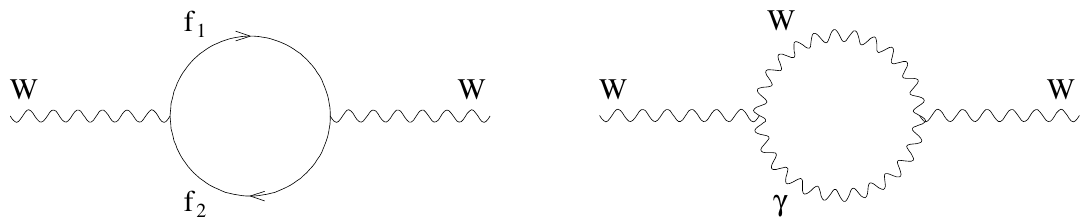
Figure 1. Fermion (left panel) and photon- W (right panel) bubble graphs relevant to the W self- energy one-loop correction, that contribute to (cid:6) f 1 f 2